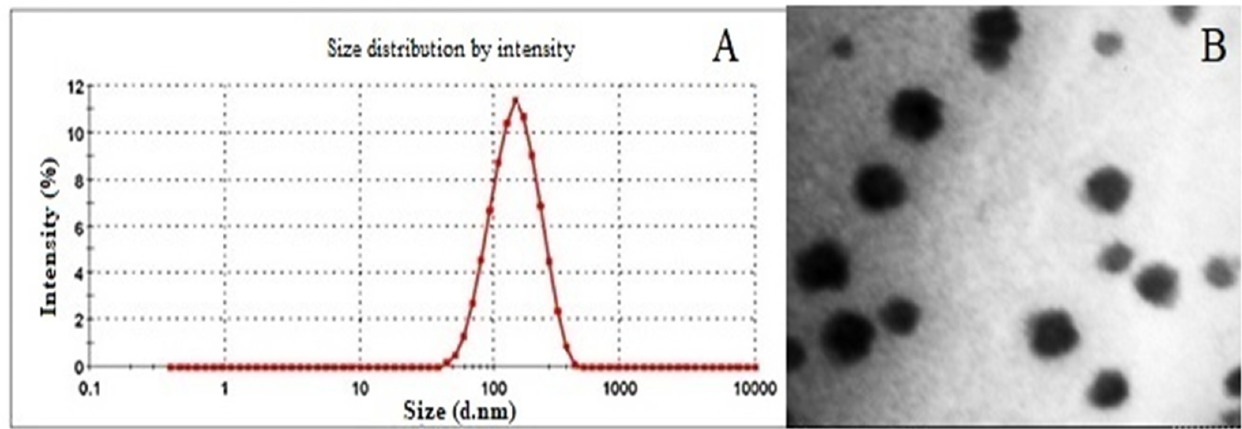
Figure 2. ( A ) Particle size (114.9 nm) of optimized formulation measured by Malvern Zetasizer 4 (Malvern Instruments). ( B ) TEM photograph of Cur-SLNs showing spherical shape and smooth surface.